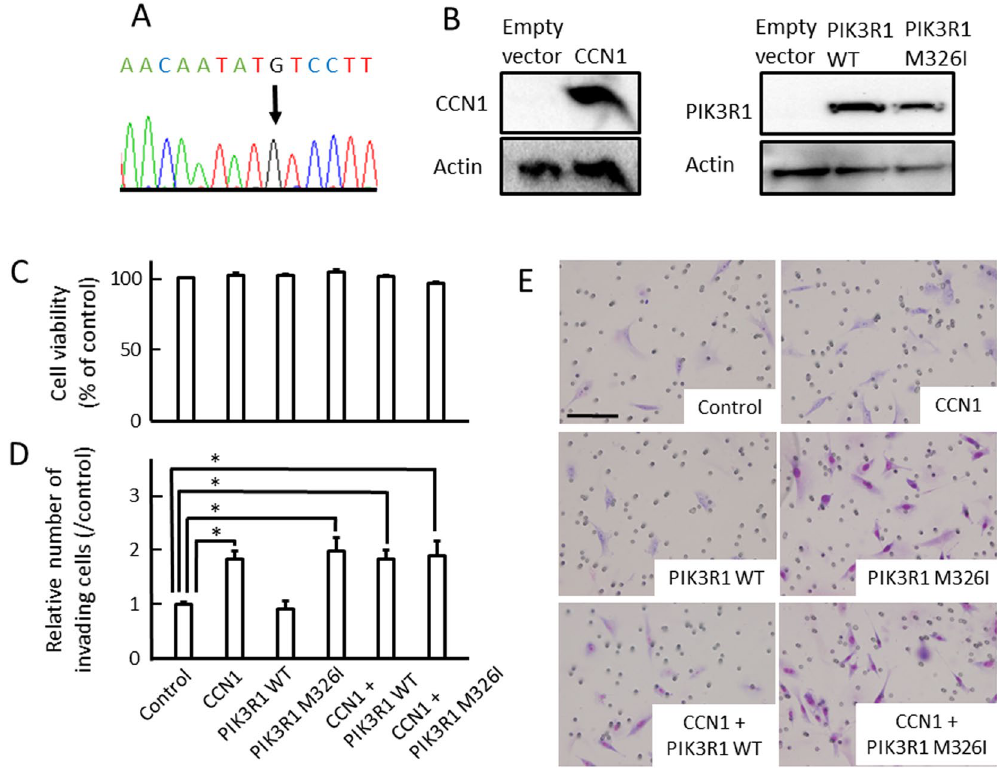
Figure 6. The role of PIK3R1Met326Ile on cell process. (A) Sequencing of PIK3R1 in U87MG. ( B ) Western blotting of CCN1 and PIK3R1 protein in U87MG cells transfected with the indicated plasmids. Full-length blots are presented in Supplementary Figure S2. ( C ) WST-1 assays for cell proliferation in U87MG cells transfected with the indicated plasmids (n = 5). ( D , E ) Migration assays in U87MG cells transfected with the indicated plasmids (n = 3). Quantification of migrated cells are shown on the graph in D . Representative images of each cell transfection group are shown in E . Statistical significance was calculated by ANOVA with Dunnett’s post hoc test. * p < 0.05. Data in C and D are shown as the mean ± SEM. Scale bar = 100 μ